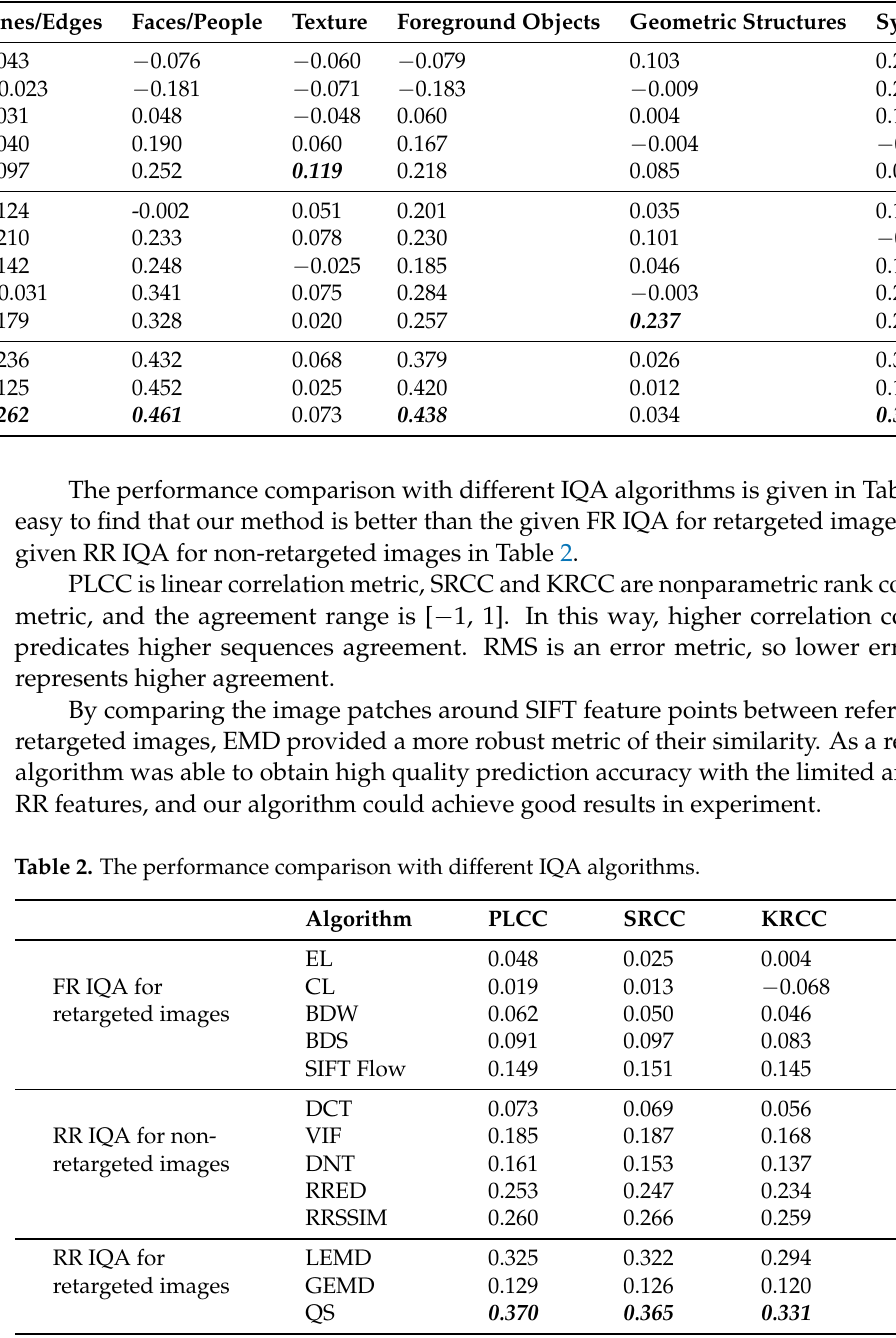
Table 1. Correlation scores of subjective and objective measures for the KRCC according to image attributes. Highest score in each column appears in bold.